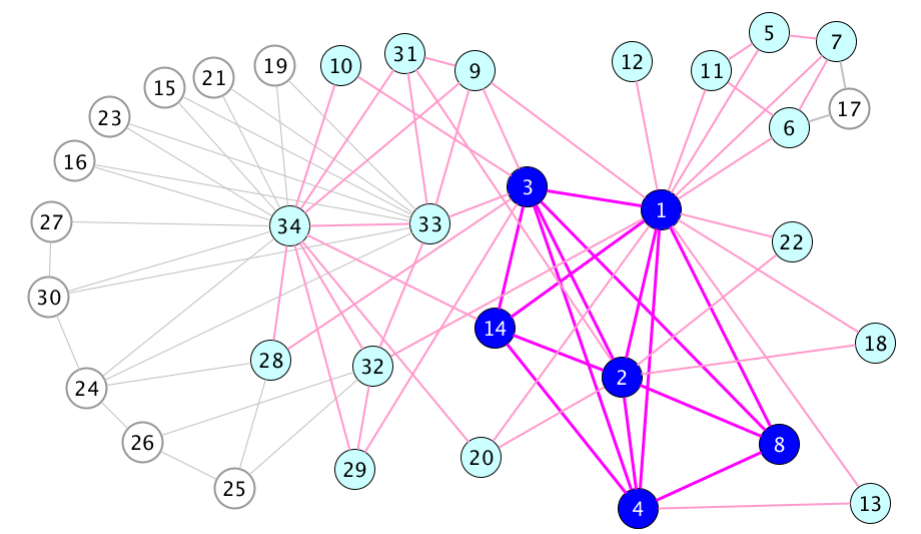
Figure 6. The Karate network, in dark blue the nodes belonging to the maximal 0.5-quasi-clique for nodes 4 and 8. In light blue the nodes being part of the first and second neighborhood graph of node 4 that are not members of the optimal